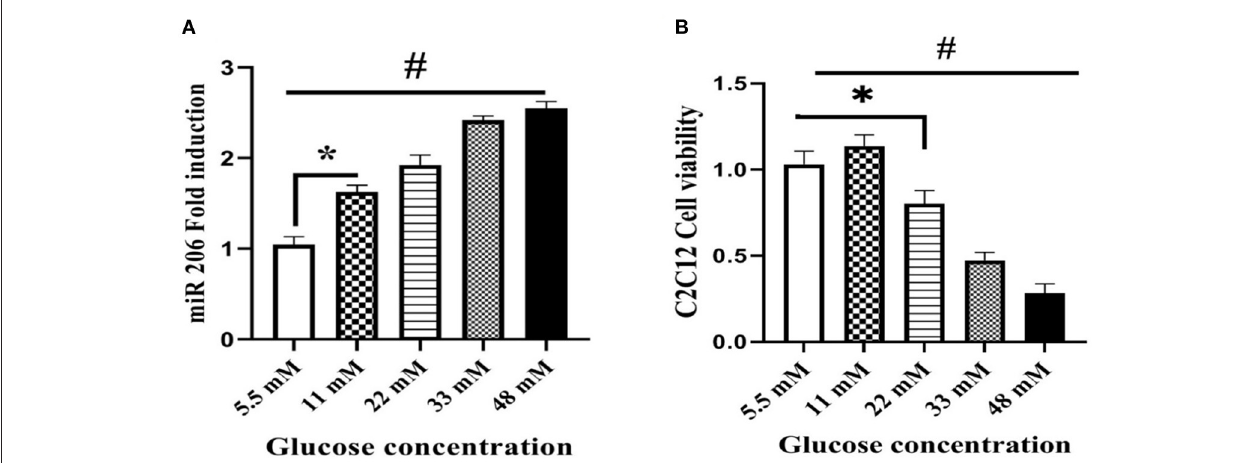
FIGURE 4 | Effect of different glucose concentrations on miR-206 expression and viability of C2C12 cells. (A) miR-206 expression (B) cell viability. Data are presented as means ± standard error of the mean (SEMs). n = 6. C2C12 cells treated for 24h with high glucose DMEM media, *Significant differences between normal glucose and high glucose, and # significant differences between different glucose